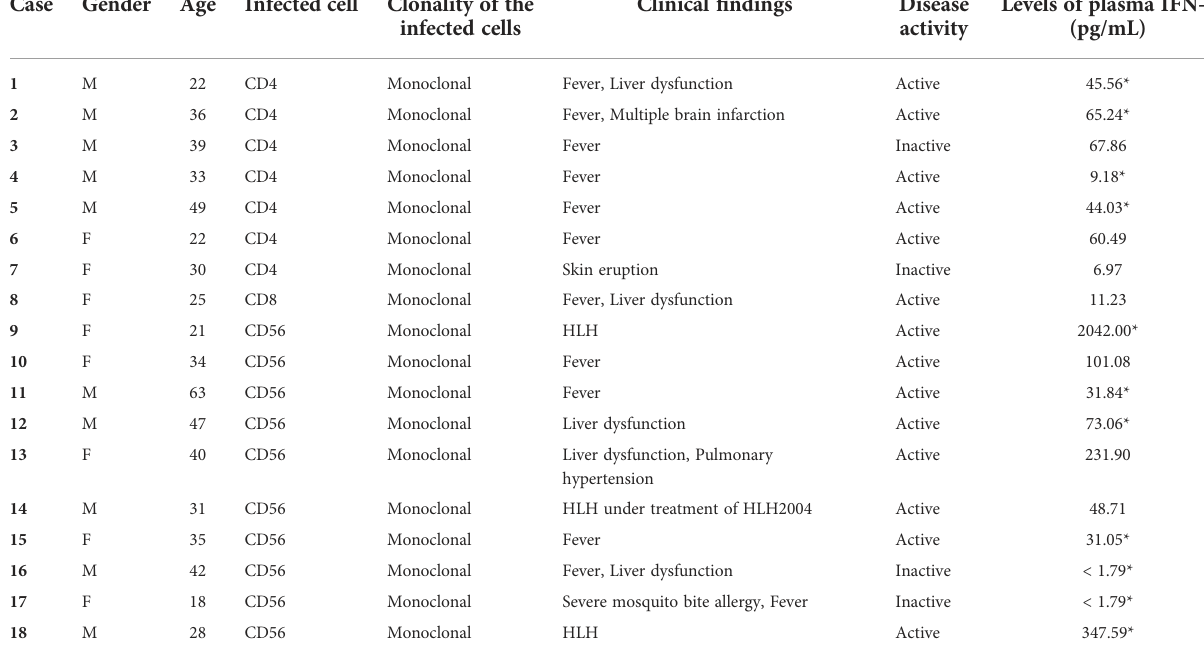
TABLE 1 The characteristics of the